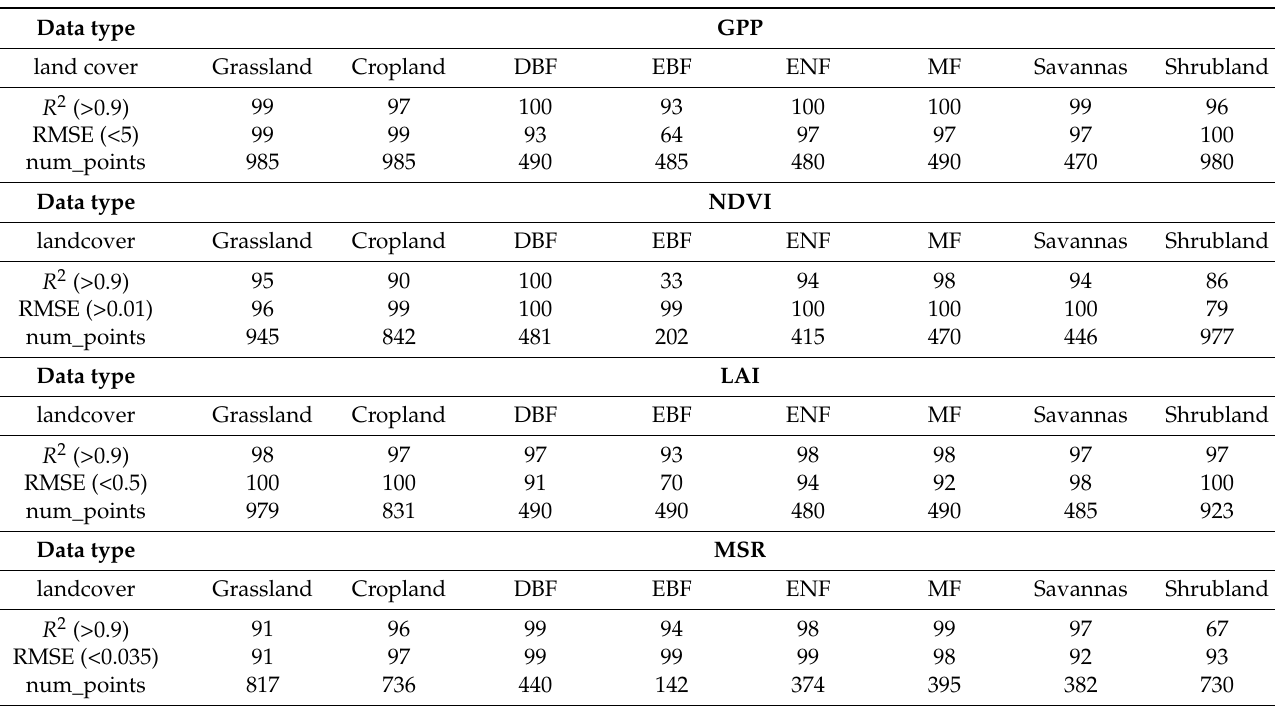
Table 2. Statistics of the percentages of sampling points in the threshold range after